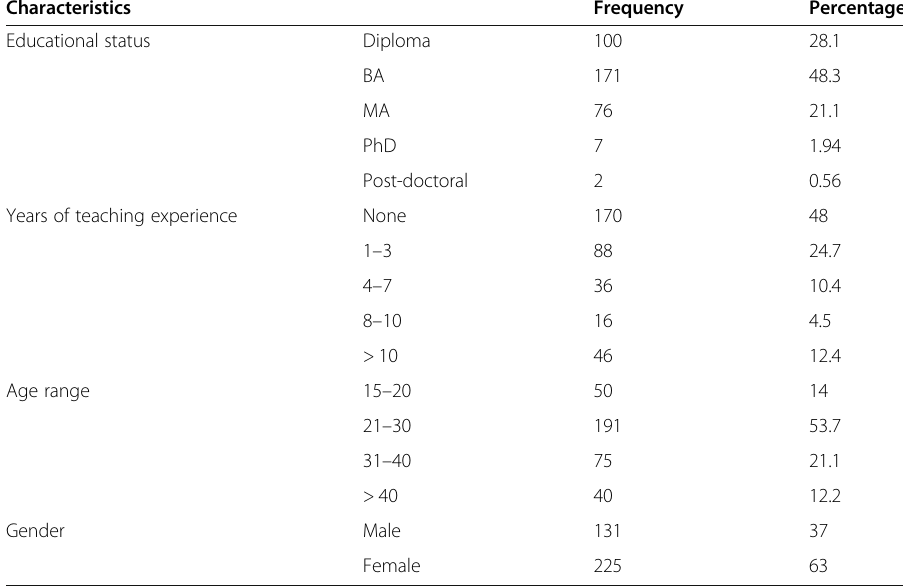
Table 1 Demographic information of the participants in the study